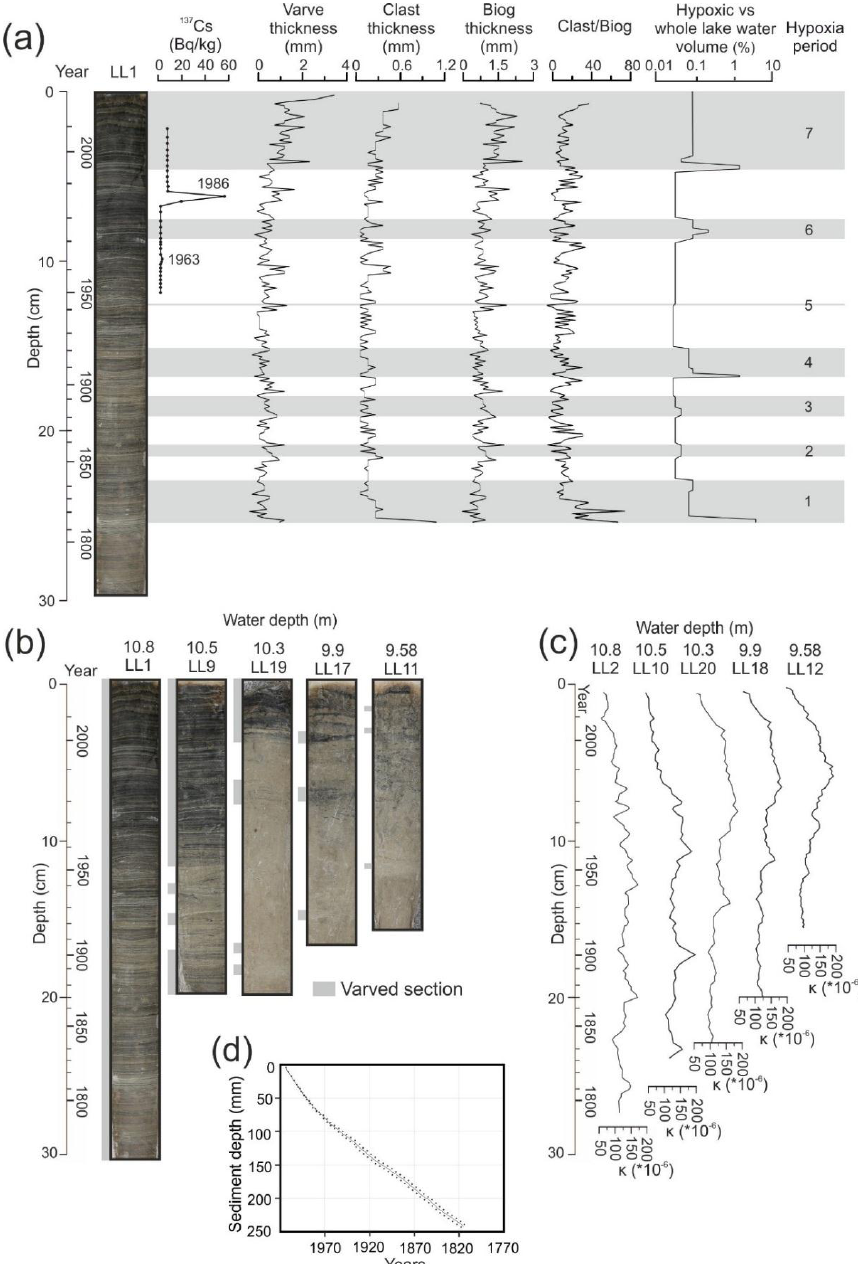
Figure 5. Sediment characteristics and dating: ( a ) Photography of core LL1 (water depth: 10.8 m), 137 Cs activity measured from LL1 and variations in varve thickness, clastic (Clast) and biogenic (Biog) lamina thicknesses, as well as clastic/biogenic lamina thickness (Clast/Biog) ratio. Hypoxia volume from 1815–2014 and hypoxia periods (gray bars) are also provided. Hypoxia volume is displayed on a logarithmic scale. ( b ) Example of sediment appearance in freeze cores along the AB transect of Lake Lehmilampi and ( c ) example of variations in magnetic susceptibility (κ). Core codes and water depths are provided. Varved sections are marked with gray bars to the left of the photographs. Note that the depth scale is valid for all cores, while the time scale represents only the master core LL1. ( d ) Age versus sediment depth curve with estimated varve counting error (dashed lines) for core LL1.